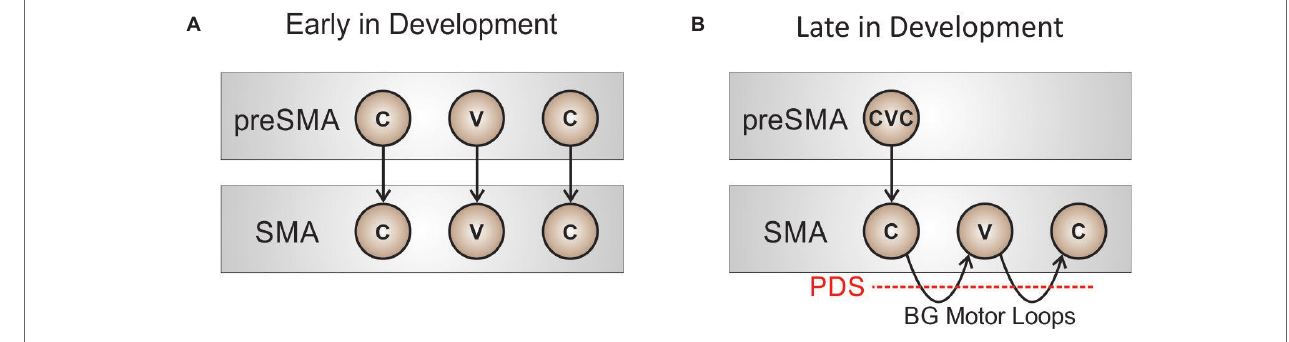
FIGURE 2 | Schematized view of the process of sequencing through phonemes in the word “pet” at two developmental stages: (A) early in development, when pre-SMA involvement is required to sequentially activate nodes in SMA for initiating each phoneme, and (B) later in development, when the basal ganglia motor loop has taken over sequential activation of the SMA nodes.